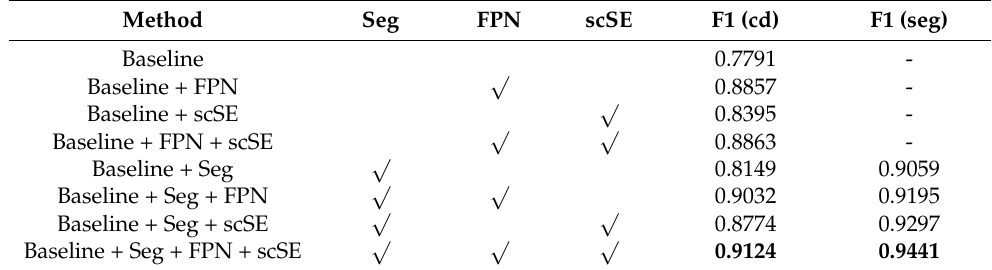
Table 2. Ablation study of segmentation branch, FPN, and scSE module on the BCDD